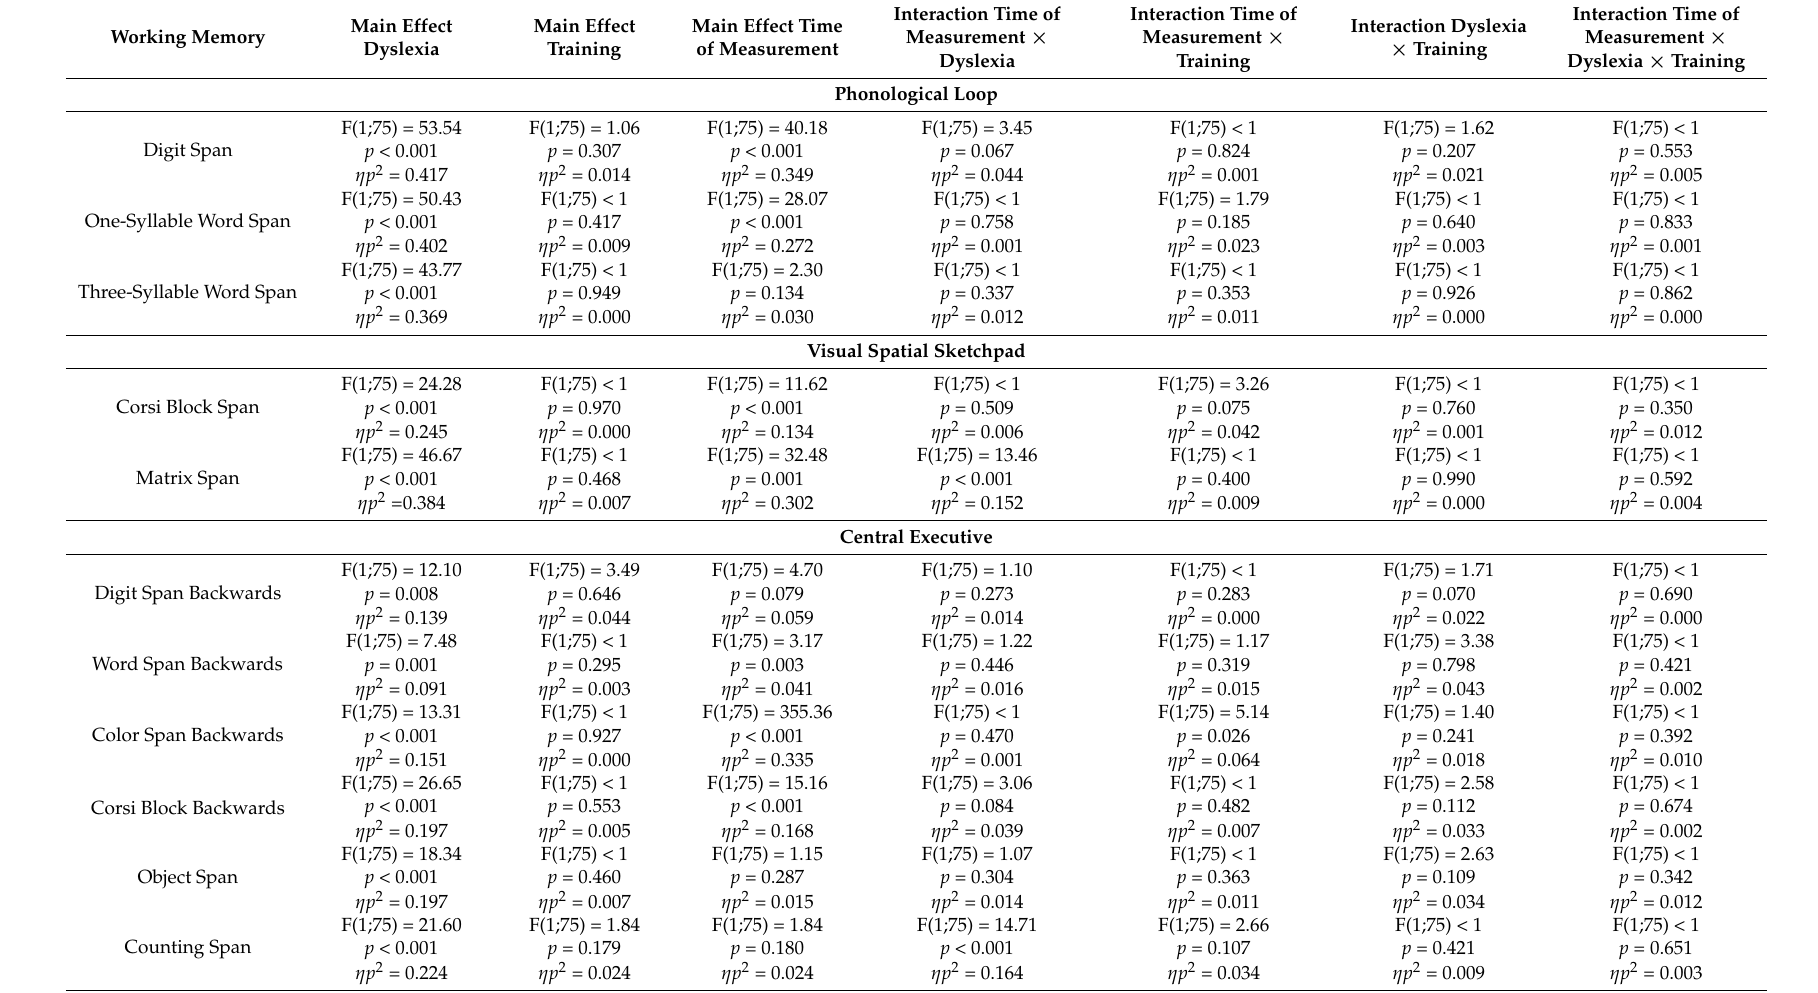
Table 5. Results (ANOVA) median